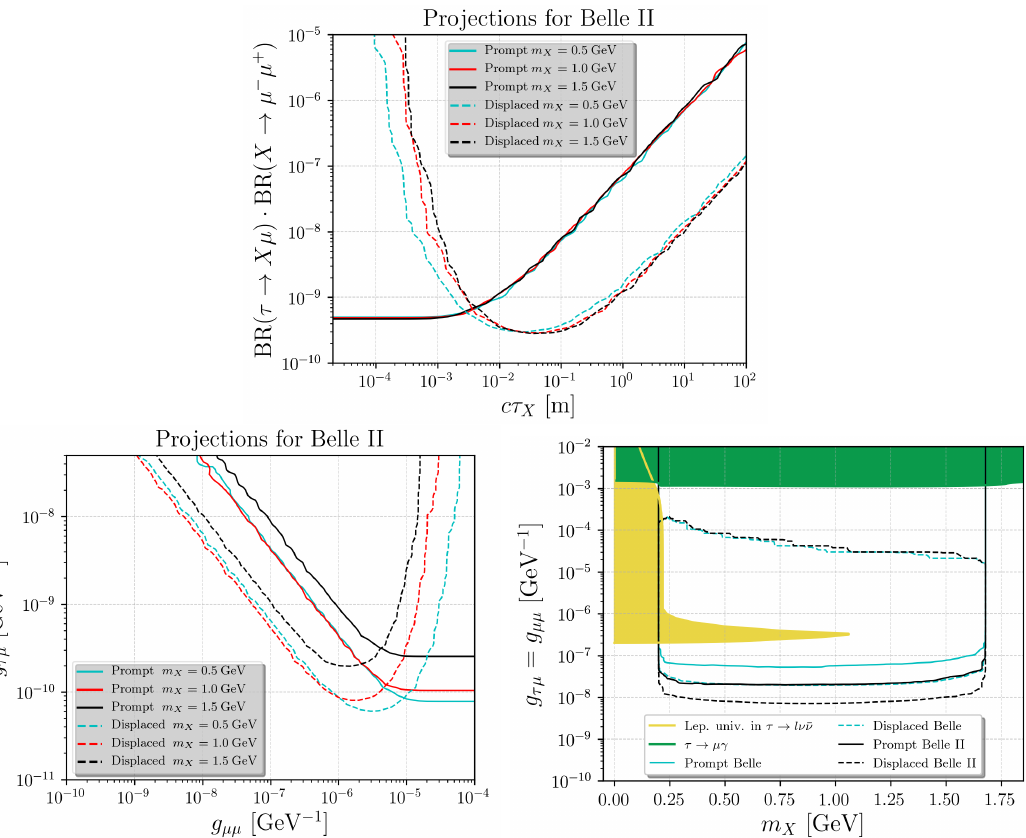
Figure 9 . Sensitivity results for Scenario 2 ( g τµ and g µµ are non-zero). The format is the same as in figure 7, except for the different mass